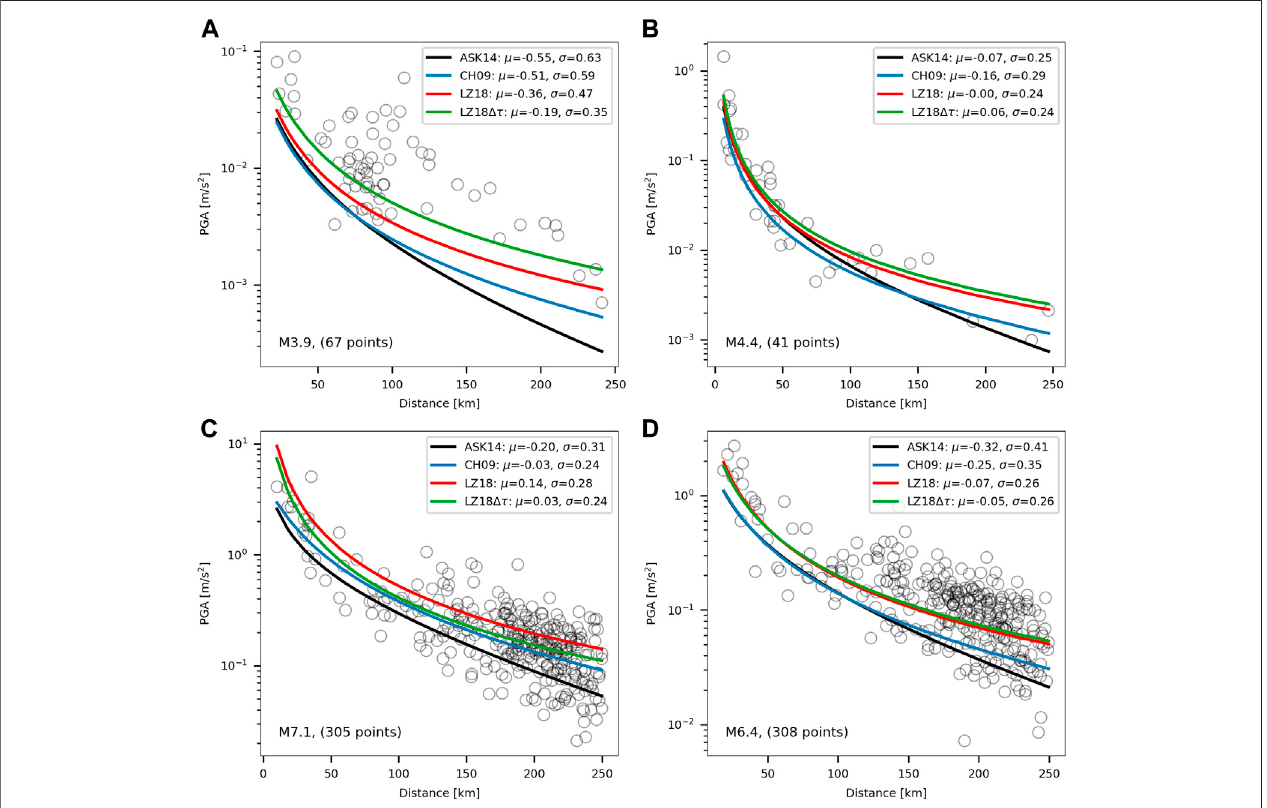
FIGURE 6 | PGA as a function of distance for (A) MW 3.9 in the eastern Mediterranean Sea, (B) MW 4.4 in north Israel, and (C) MW7.1 and (D) MW6.4 near Ridgecrest California. Magnitudes and the number of data points are indicated at the bottom left corner of each panel. The GMPEs of LZ18, ASK14, CH09, and LZ18 withearthquakespeci fi cstressdrop (LZ18 Δτ )are indicated byred, black, blue and green curves, respectively. Averagediscrepancies ( μ )and standard deviations tothe residuals ( σ ) are indicated in the legends.